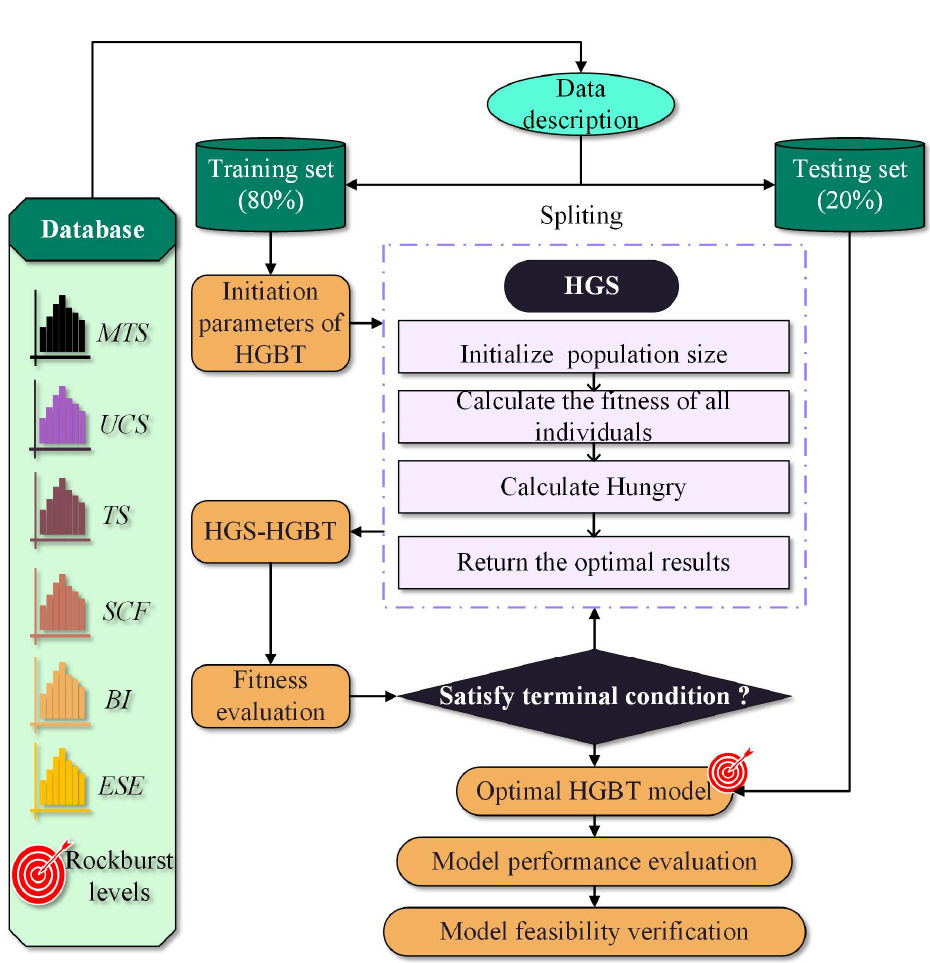
Figure 7. The technique flowchart of this study.